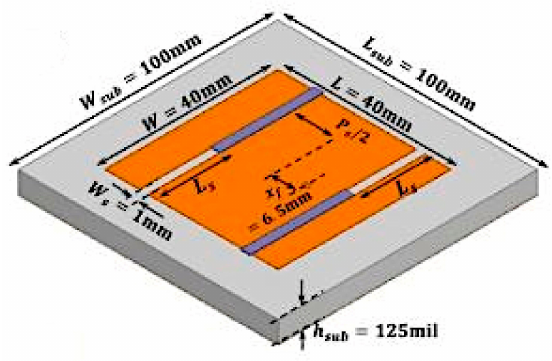
Figure 7. Patch antenna with two slotted patches